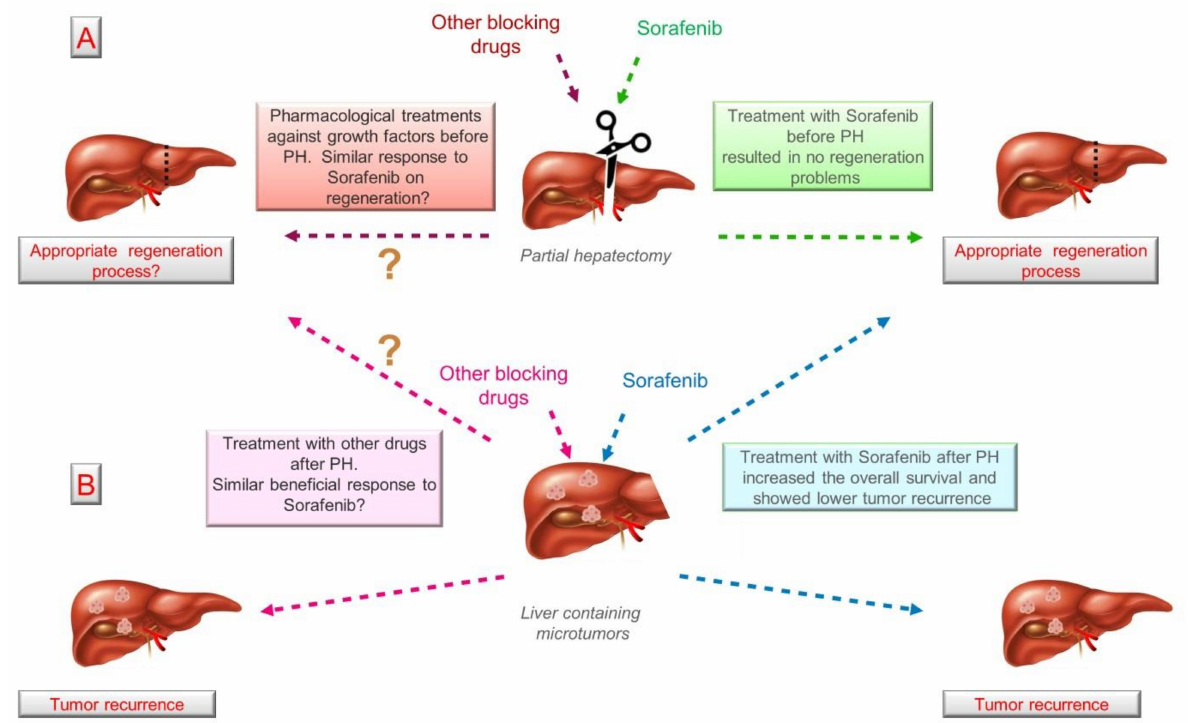
Figure 3. Pharmacological regulation of growth factors and its effect on regeneration and cancer recurrence. ( A ) According to the limited number of studies, treatment with Sorafenib seems does not to affect liver regeneration and could provide benefits to patients after liver resection. ( B ) No other drugs targeting HGF, EGF, and IGF-1 have been tested with similar objectives. ? means unknown. Abbreviations: EGF; epidermal growth factor; HGF, Hepatocyte growth factor; IGF-1, Insulin-like growth factor 1; PH, partial